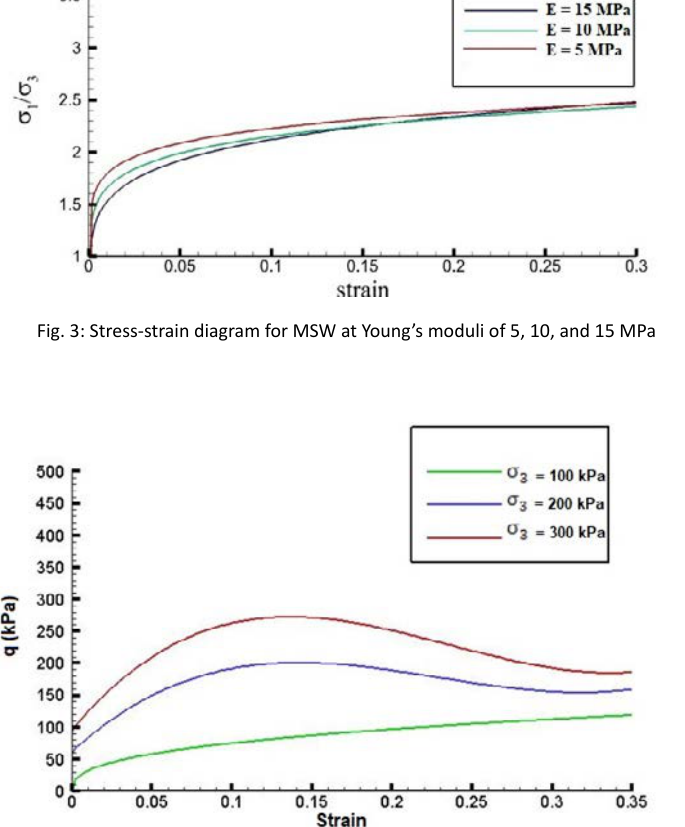
Fig. 4: Stress-strain diagram for fiber at confining stresses of 100, 200, and 300 Fig. 4: Stress‐strain diagram for fiber at confining stresses of 100, 200, and 300 kPa